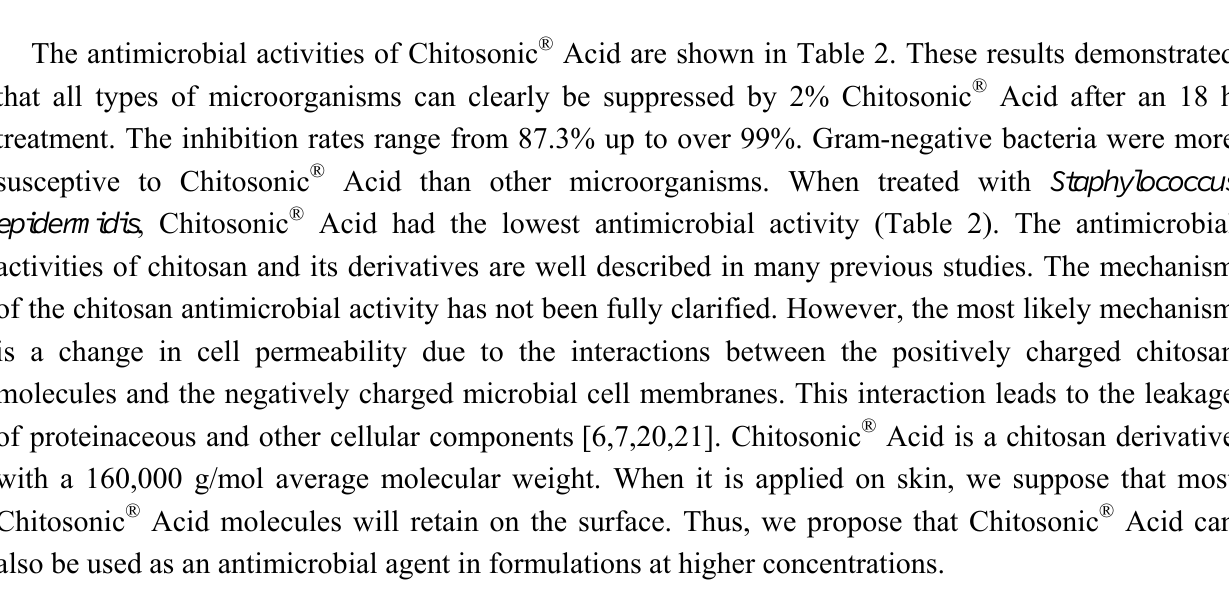
Table 2. Antimicrobial and antioxidant activities of Chitosonic ®